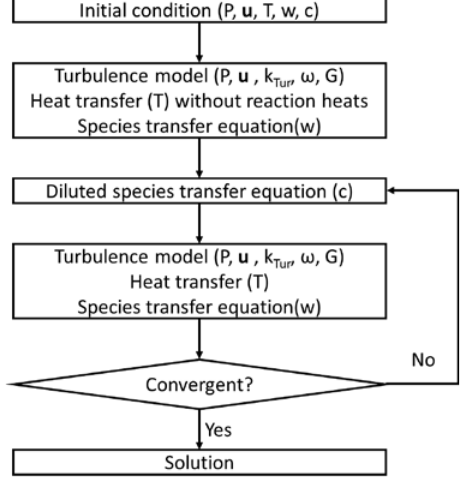
Figure 2. Computing sequence diagram.